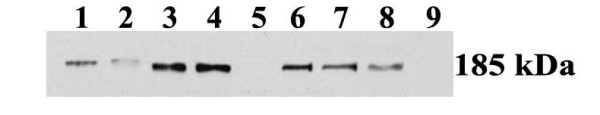
Reactivity observed by western immunoblot with the Dako Cytomation anti-HER-2/neu antibody in 4 feline mammary tumors. Lanes 1-4: Feline mammary tumors; Lanes 5-8: non-neoplastic feline mammary tissues; Lane 9: feline liver. The molecular weight of the reactive protein band is indicated on the right.